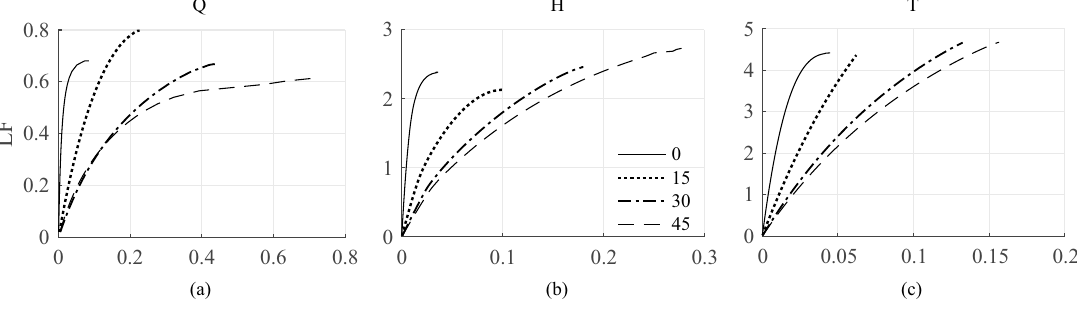
Figure 8: Load-displacement curves for each pattern and orientation angle